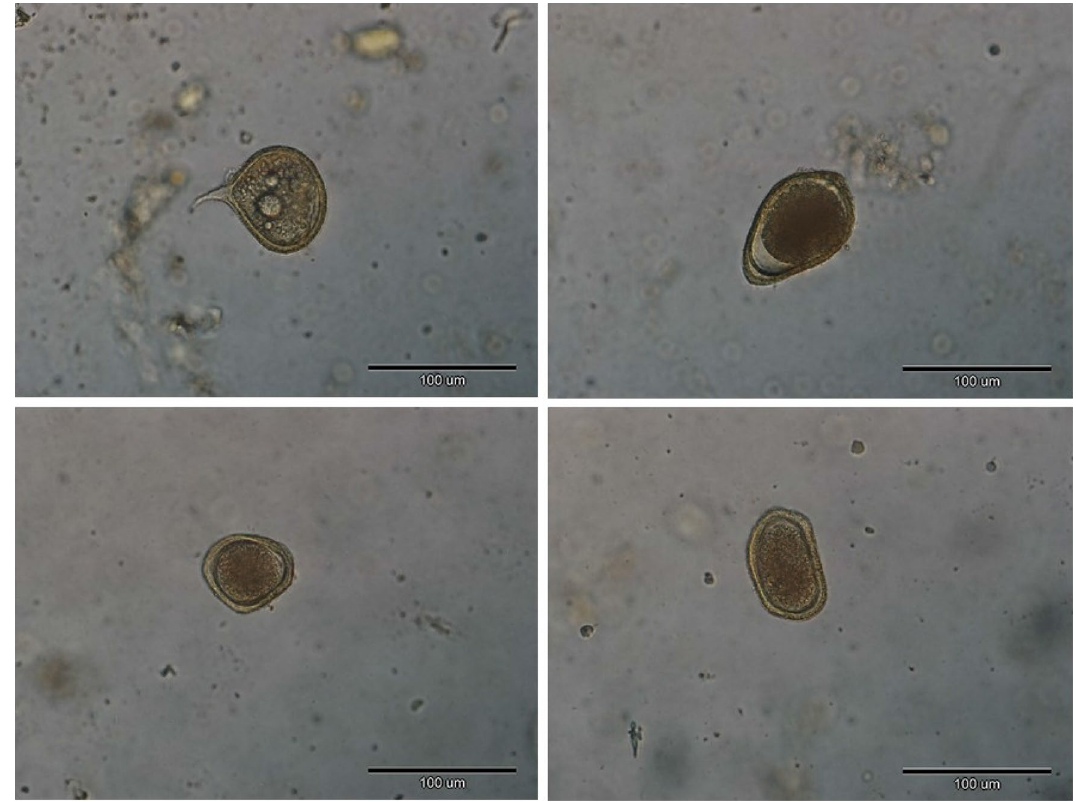
Figure 2. Toxocara spp. eggs found in soil collected from open grasslands located in Site 4. Pictures show unembryonated eggs with typical golden colour, spherical to slightly pear shaped, thick-shelled, and a pitted surface. Black bar indicates 100